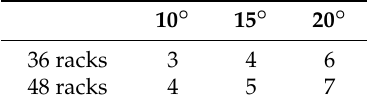
Table 2. The number of direct inter-rack links one FSO node can establish.